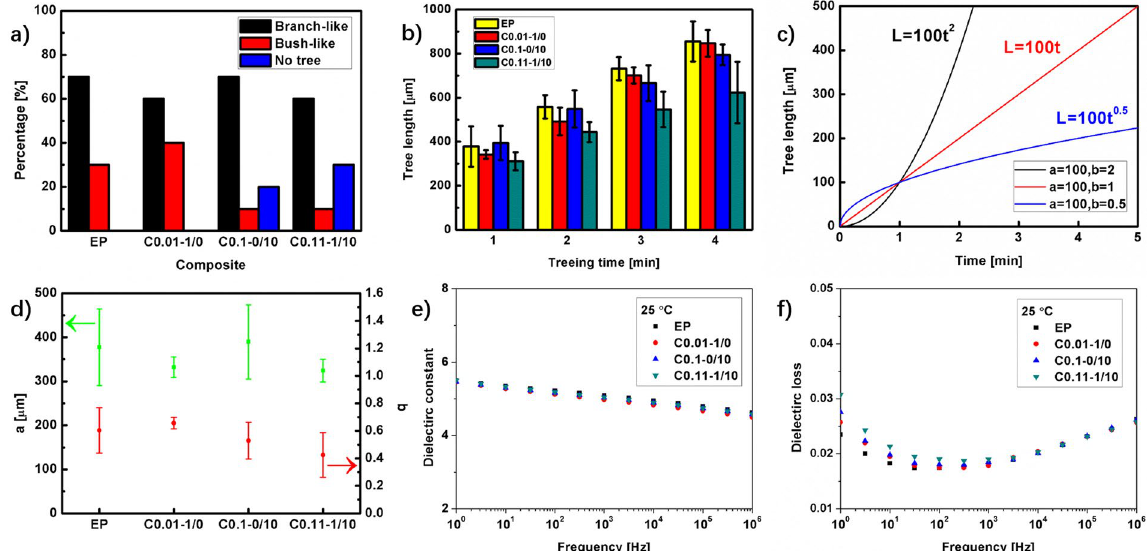
Figure 4. ( a ) The percentages of the electrical tree shapes: branch-like, bush-like and no tree. ( b ) The average tree length of the composites in first 4 min. ( c ) Three patterns of the electrical tree growth. ( d ) The length parameter a and the speed parameter b of the composites. ( e ) The dielectric constants and ( f ) the dielectric losses of the epoxy/SiO2 composites.